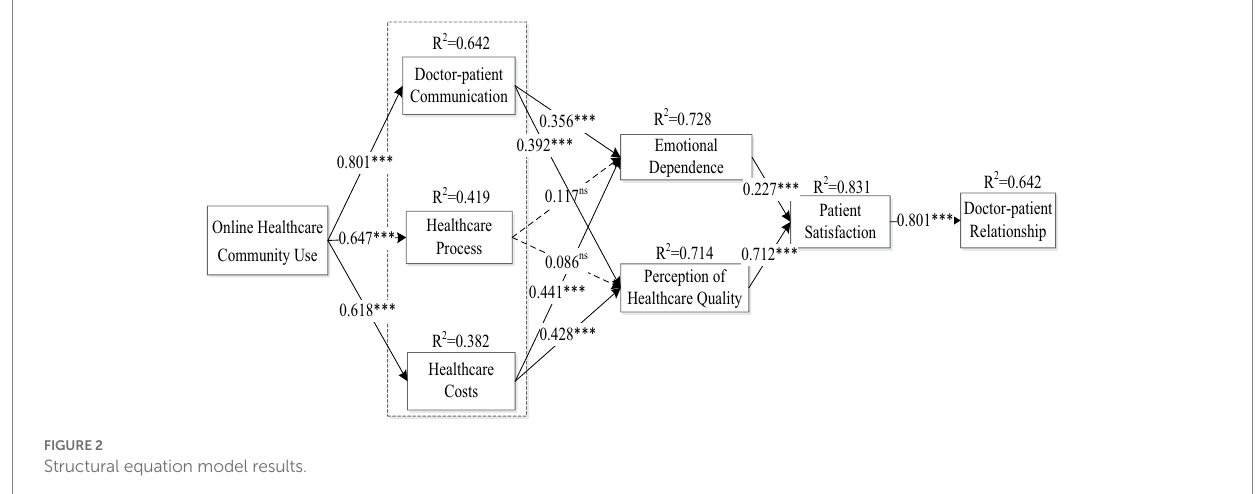
FIGURE 2 Structural equation model results.